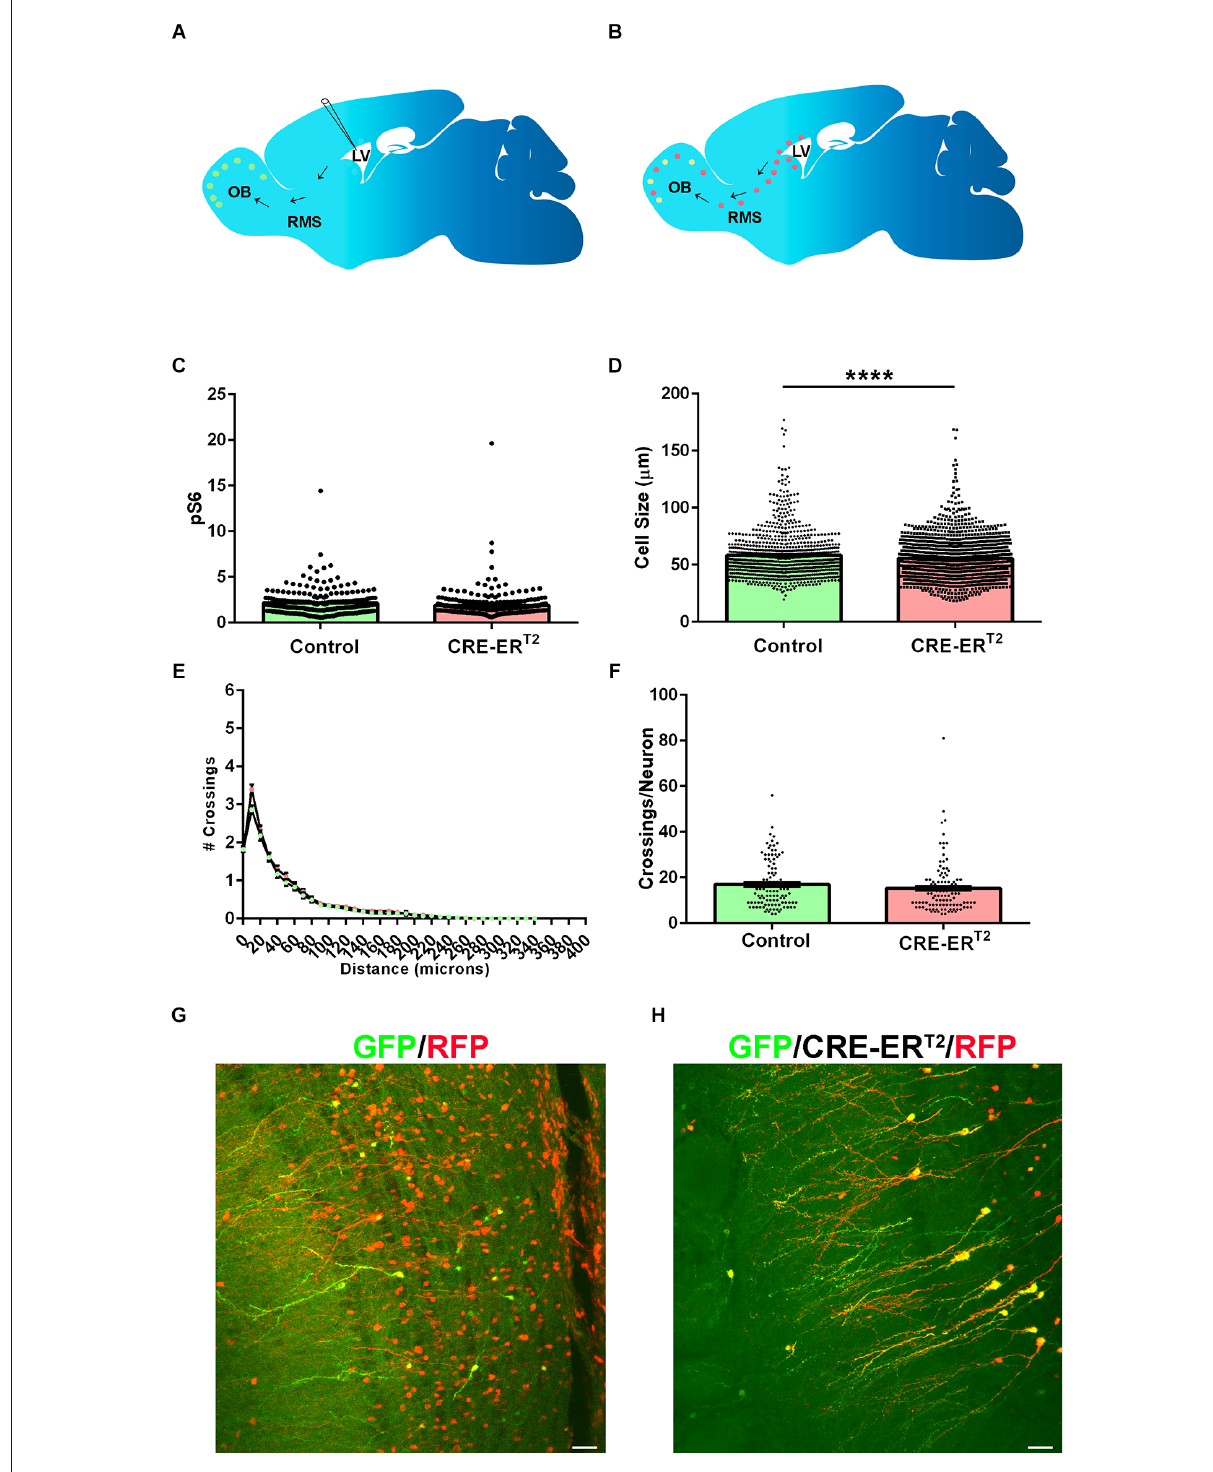
FIGURE7 Loss of Tsc2 in mature GCs has modest effects on morphology. (A) Schematic diagram of neonatal electroporation and presence of GFP OB GCs prior to recombination at P30. (B) Schematic diagram of neonatal electroporation with the presence of GFP and RFP positive OB GCs at P60 after P30 tamoxifen induced recombination. (C) Quantification of pS6. (D) Quantification of cell size. (E) Sholl analysis. (F) Quantification of the number of dendrite crossings per GC. (G) RFP (red) and GFP (green) cells in OB GCs in control conditions. (H) RFP (red) and GFP (green) cells in OB GCs in CRE-ER T2 conditions confirm recombination. **** p <